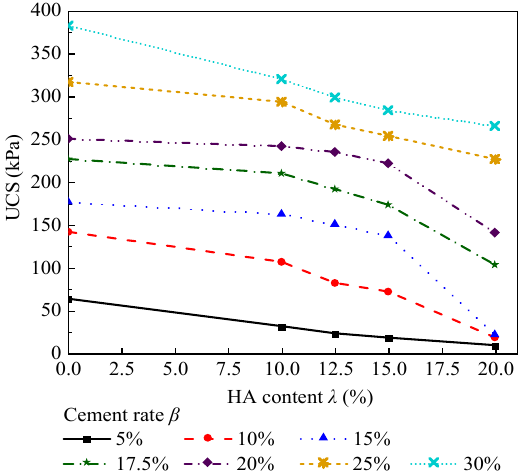
Figure 10. Relation curve between UCS and HA content.